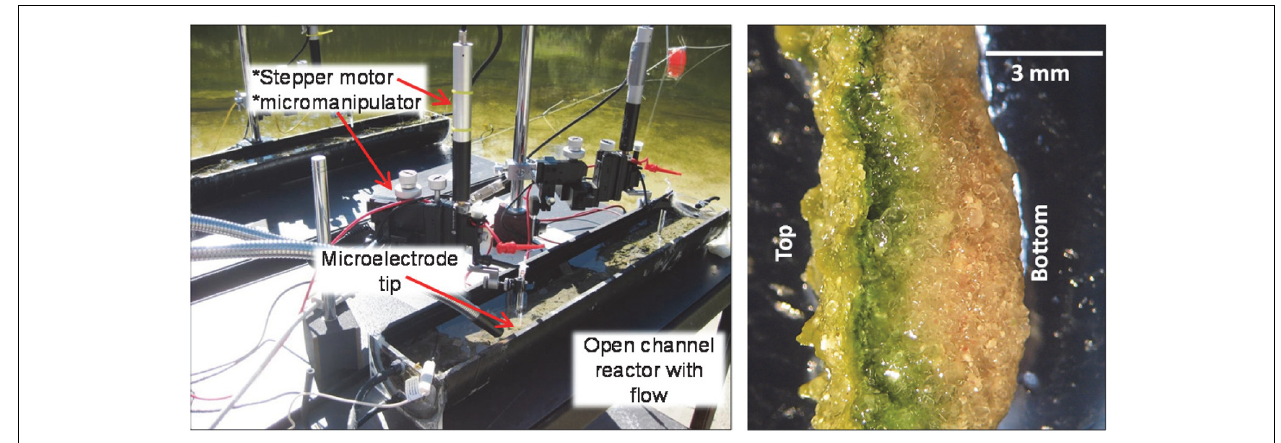
FIGURE 1 | Photo of open channel reactors containing microbial mat samples used in microprofiling (left). Stereomicroscope image of excised mat slice on its side showing stratification